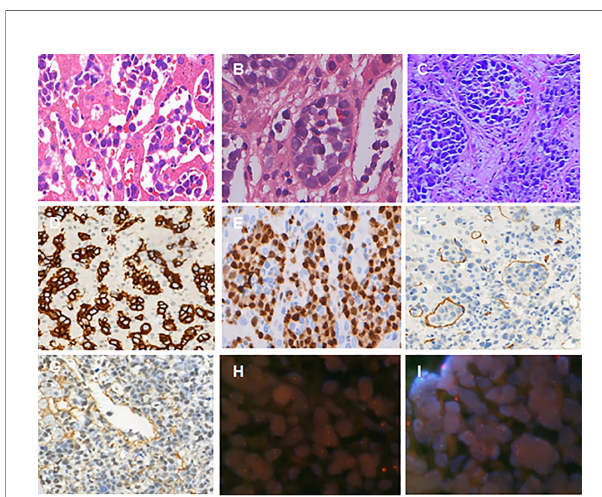
FIGURE 2 | Histologic features of IVLBCL from the percutaneous organ biopsy specimens. (A) A liver biopsy demonstrated intermediate to large cells within sinusoids with irregular nuclei, dispersed chromatin, occasional nucleoli, and scant cytoplasm (case 1). (B) Cellulose thrombosis could be found (case 2). (C) Lymphoma cells were large, with scant cytoplasm, prominent nucleus, and frequent mitotic fi gures (case 3). (D – G) Immunophenotypic features of IVLBCL. The neoplastic cells were positive for CD20, MUM1, CD31, and EBER (original magni fi cation D-G, ×200); FISH study showed non-rearrangement of C-MYC , BCL2 , or BCL6 gene on the IVLBCL cells. Non-rearranged gene is represented by orange/green fusion signal (H, I)